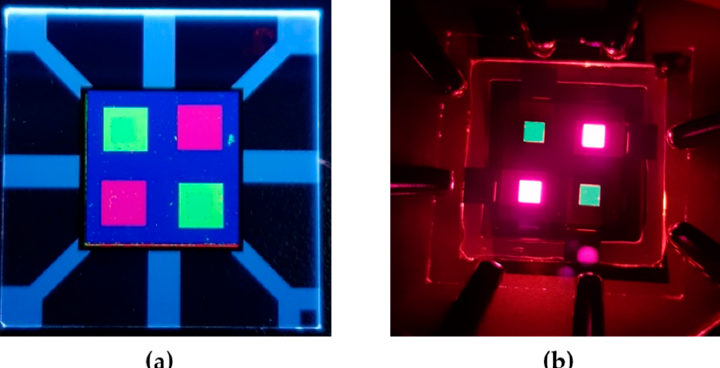
Figure 10. ( a ) Photoluminescence (PL) image of the processed device under UV lamp excitation; ( b ) electroluminescence (EL) image of the device after two-color pixel patterning.